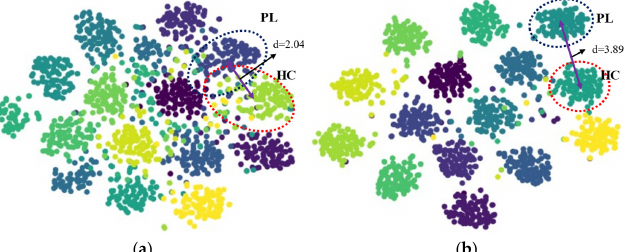
Figure 11. Visualization using t ‐ SNE on DOTA1.0 dataset. ( a ) Baseline. ( b ) Baseline + PCLM.